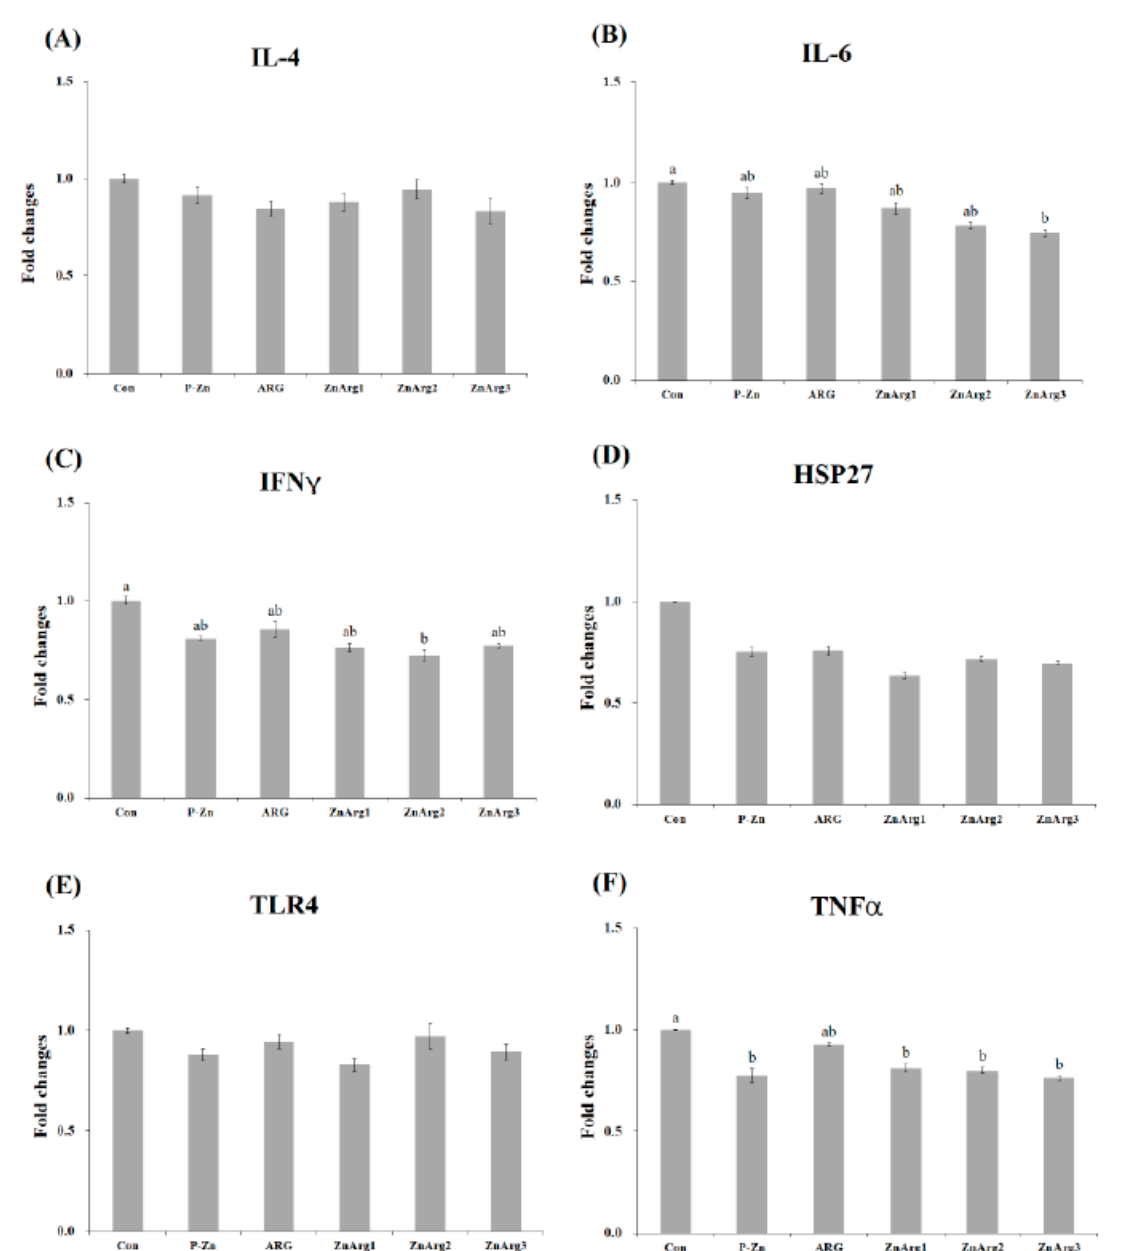
Figure 2. Relative expression of, ( A ) interleukin-4 (IL-4), ( B ) interleukin-6 (IL-6), ( C ) interferon- γ (IFN γ ), ( D ) heat shock protein-27 (HSP27), ( E ) toll like receptor-4 (TLR4), and ( F ) tumor necrosis factor- α (TNF- α ) in the liver of weanling piglets. Error bars represent standard error of means. Bars with different letters (a~b) differ significantly across all 6 treatment groups ( p < 0.05). Con: 1.1% Arg; P-ZnO: 1.1% Arg + 2500 mg Zn/kg diet; ARG: 1.6% Arg; ZnArg1: 1.6% Arg + 500 mg Zn/kg diet; ZnArg2: 1.6% Arg + 1000 mg Zn/kg diet; ZnArg3: 1.6% Arg + 2500 mg Zn/kg diet.